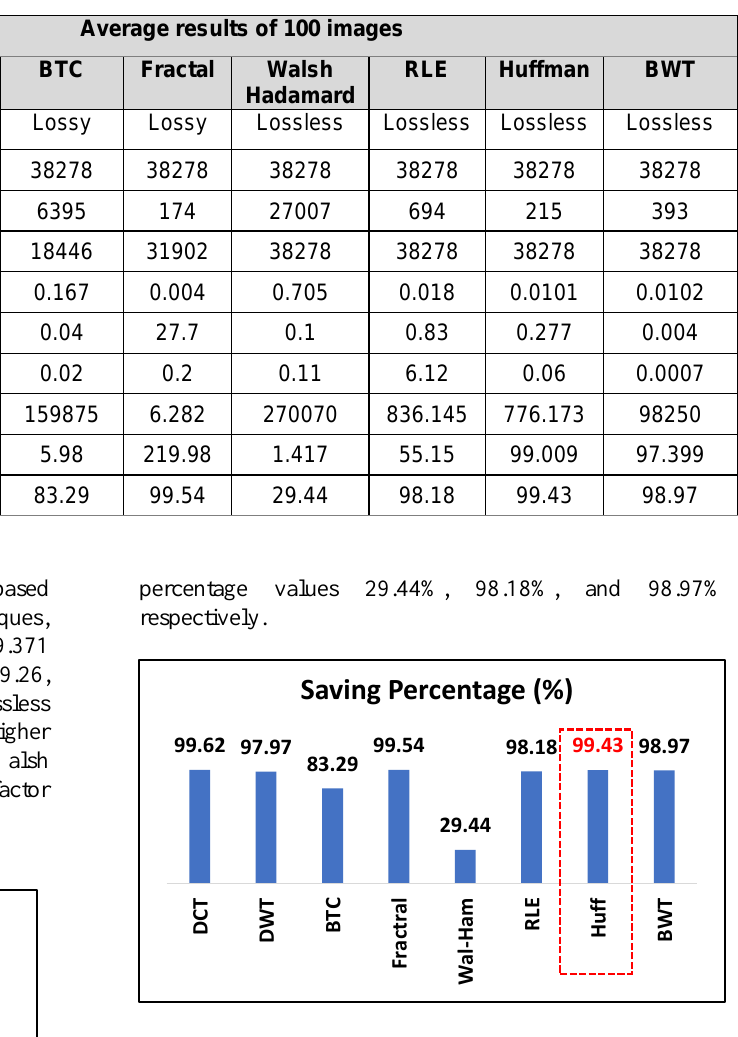
Table 1. Comparative Analysis of Lossy and Lossless compression algorithms